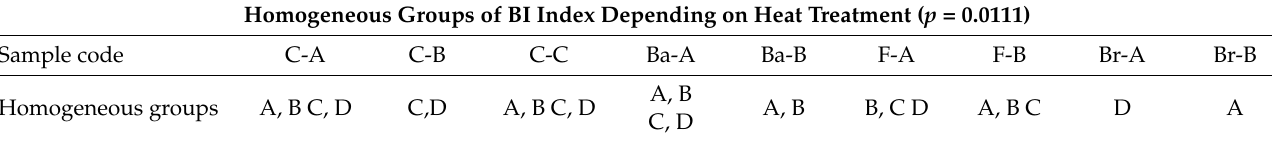
Figure 1. Browning index [BI] results of chicken breast fillet samples. Code designations as in Table 1 data for calculating BI—Table S1 in Supplementary Materials. Table 7. Statistical analysis of BI color index of chicken breast fillet